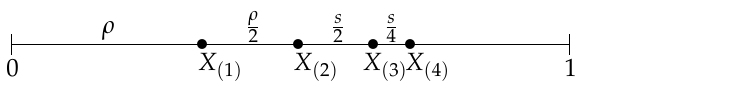
Figure 4. The positions of 4 mobile sensors X ( 1 ) , X ( 2 ) , X ( 3 ) , X ( 4 ) on the unit interval. Firstly, Algorithm 1 moves the sensor X ( X ( does not move. Then, Algorithm 1 moves the sensor X ( 2 ) 3 ρ + s , and the sensor X ( 2